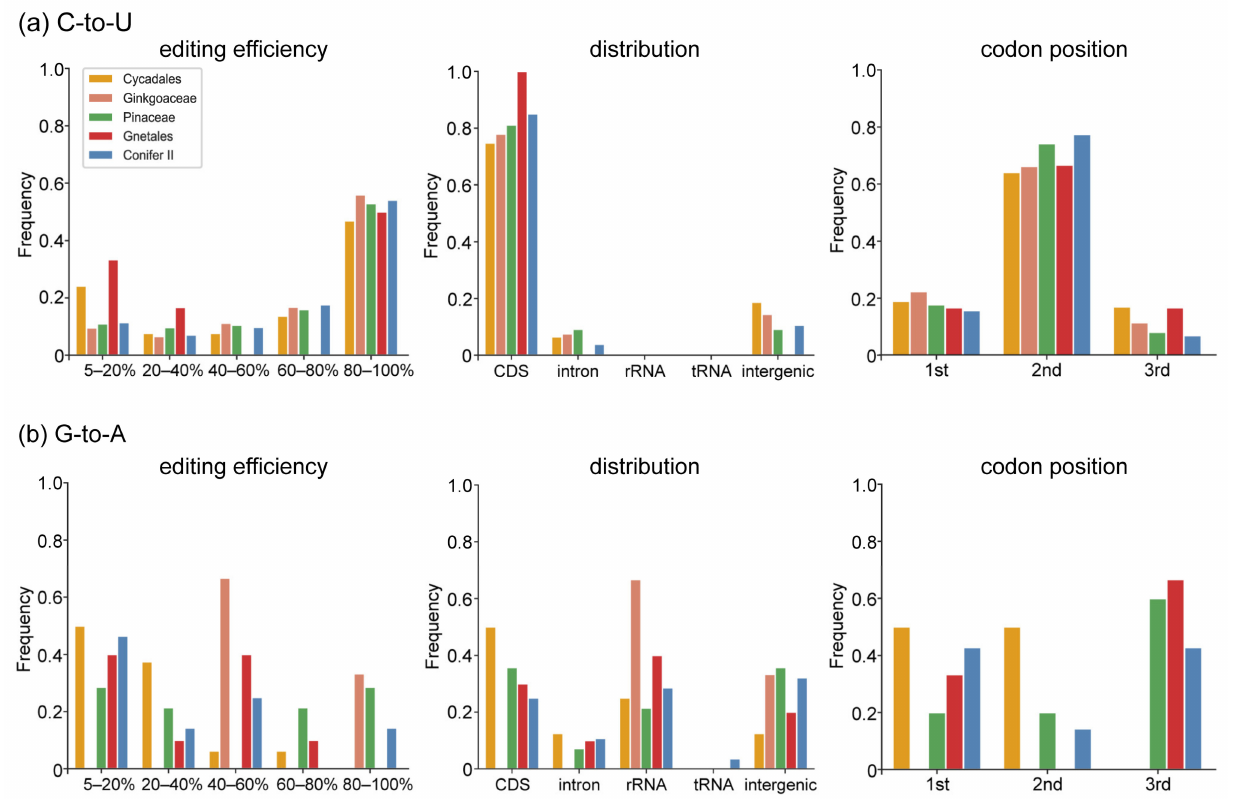
Figure 3. Comparative analyses of editing efficiency, distribution and codon position of chloroplast C-to-U ( a ) and G-to-A ( b ) RNA editing sites among five gymnosperm lineages.